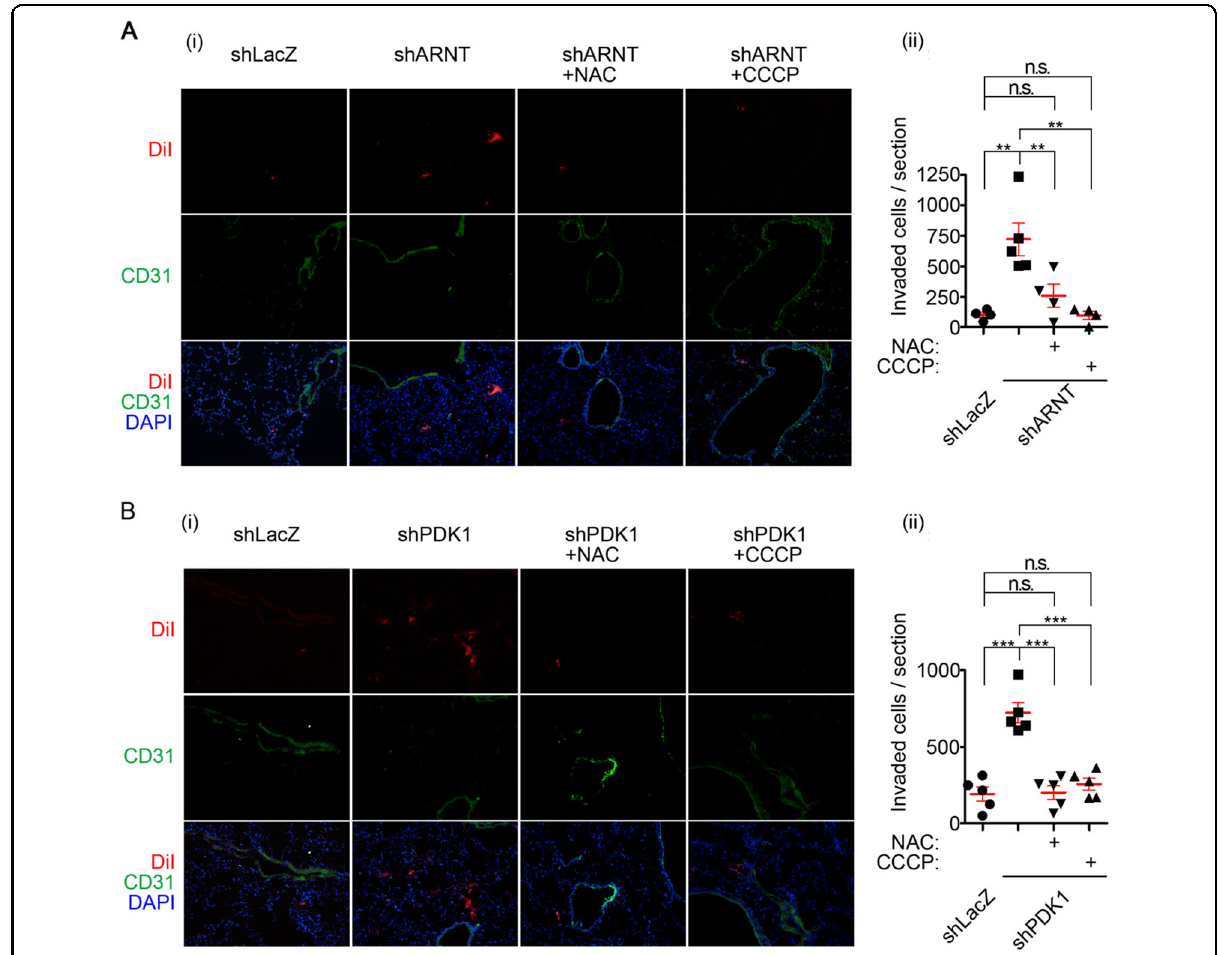
Fig. 7 ARNT de fi ciency-promoted tumor cell extravasation is mediated by oxidative phosphorylation. A – B Tumor cells penetrate to pulmonary blood vessels that was determined by in vivo extravasation assay. DiI staining of A375 cells were treated with NAC (20 mM) and CCCP (10 μ M) for 24 h and then injected intravenously into the tail vein of 6-week-old NOD-SCID mice. At 48 h after injection of tumor cells, the mice were sacri fi ced for examining of metastatic tumor cells surrounding the lung tissue as described in “ Materials and Methods ” section. Tumor cell penetration was imaged using a microscope (i). DiI labeled tumor cells (red); CD31 labeled blood vessels (green); DAPI labeled nucleus (blue). The number of tumor cell extravasation was calculated by analyzing at least four sections and six fi elds (ii); Four or fi ve mice were analyzed for each